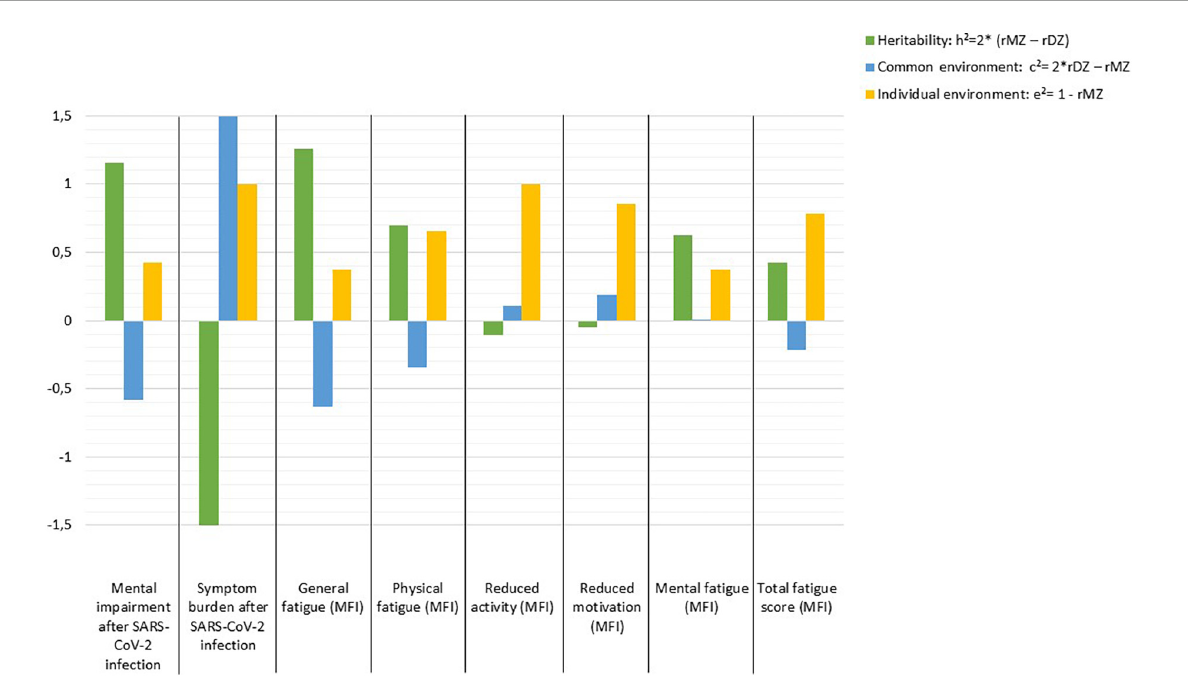
FIGURE1 Estimates of heritability (h 2 ), common (c 2 ), and individual environmental (e 2 ) effects on outcomes following SARS-CoV-2 infection according to Falconer’s